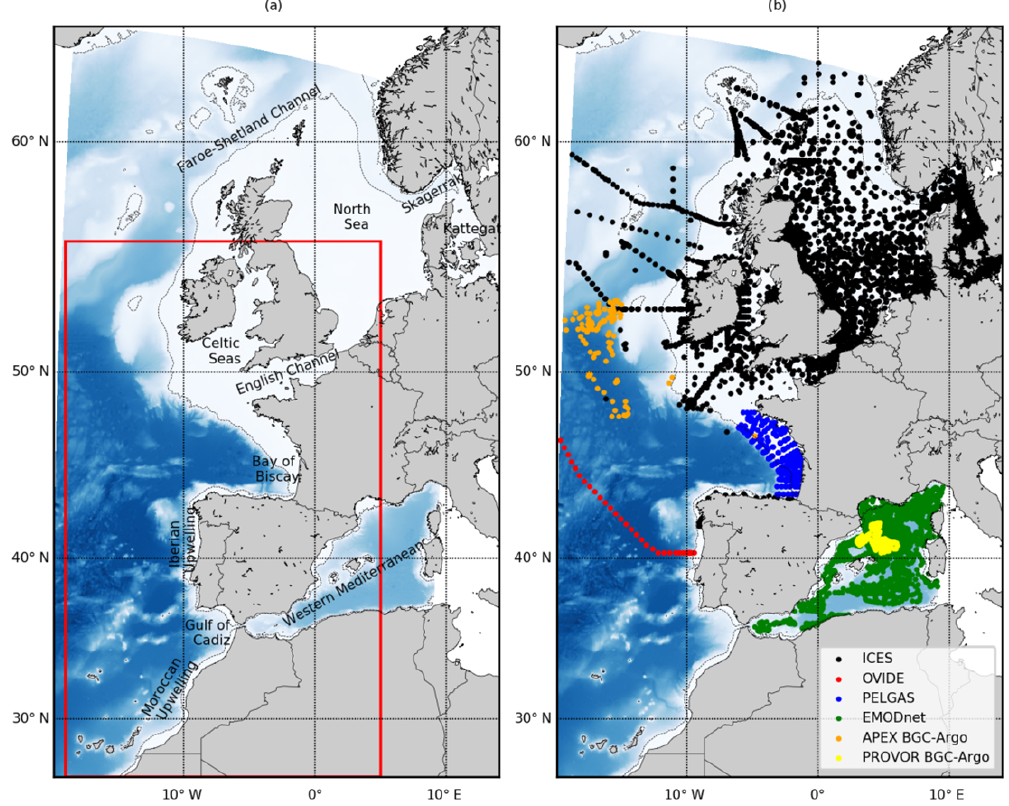
Figure 1. (a) IBI extended domain on a curvilinear grid and IBI service domain extending from − 19 to 5 ◦ E and 26 to 56 ◦ N on a regular grid (red rectangle). The 12 black boxes represent the different areas described in Sect. 2 and used for evaluation in Sect. 4. They represent the North Atlantic (boxes 1, 2, 3), North Sea (boxes 4 and 5), English Channel (box 6), Bay of Biscay (box 7), Iberian upwelling (box 8), Gulf of Cádiz (box 9), Moroccan upwelling (box 10) and western Mediterranean (boxes 11 and 12). (b) Location of in situ biogeochemical data used for validation. ICES (International Council for the Exploration of the Sea) data are in black, OVIDE (Observatoire de la Variabilité Interannuelle et Décennale en Atlantique Nord) section and PELGAS (Pélagiques Gascogne) data of the north-east Atlantic EMODnet (European Marine Observation and Data Network) dataset are, respectively, in red and blue, the Mediterranean Sea EMODnet dataset is in green, the APEX BGC-Argo float in the Atlantic is in orange, and the PROVOR BGC-Argo float in the Mediterranean is in yellow. The blue colour shading represents the bathymetry and the dashed line is the 200m isobath delimiting the shelf